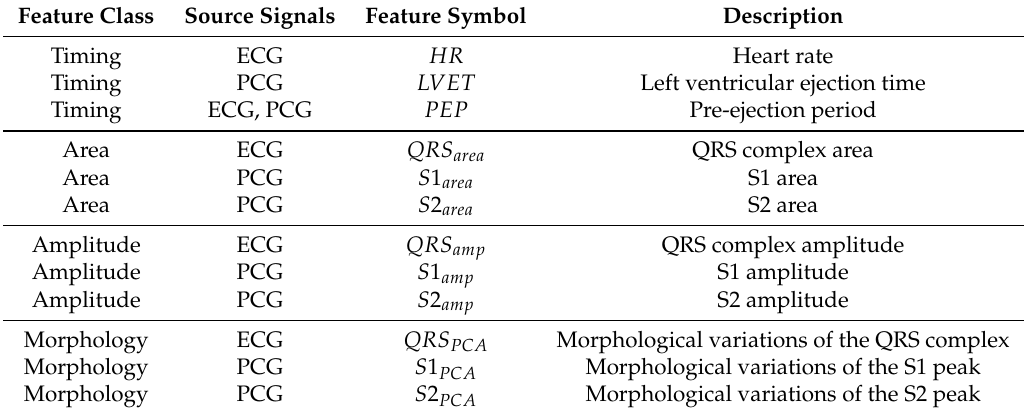
Table 1. ECG- and PCG-derived respiration